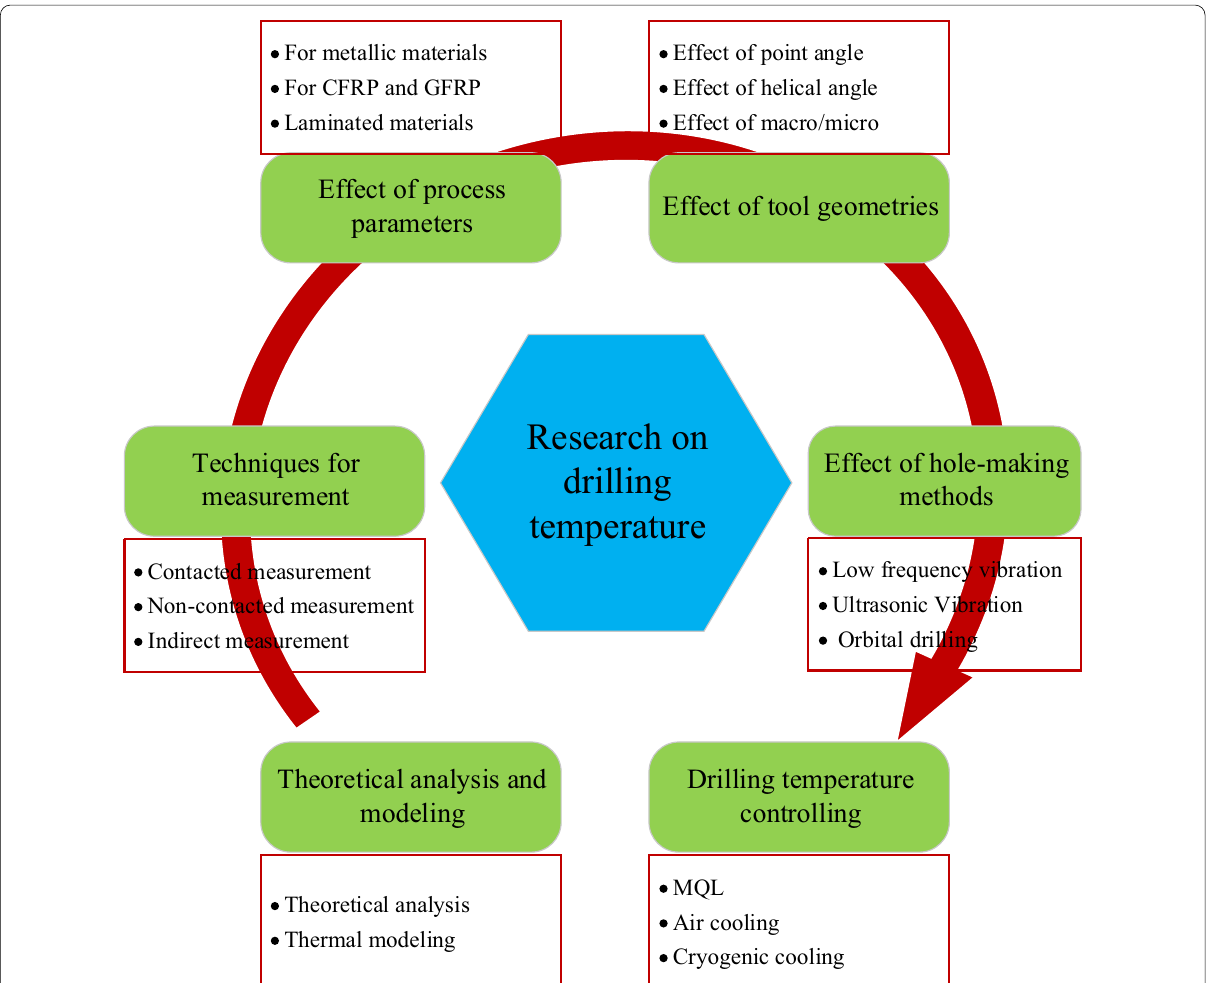
Figure 1 The flow and structure of this